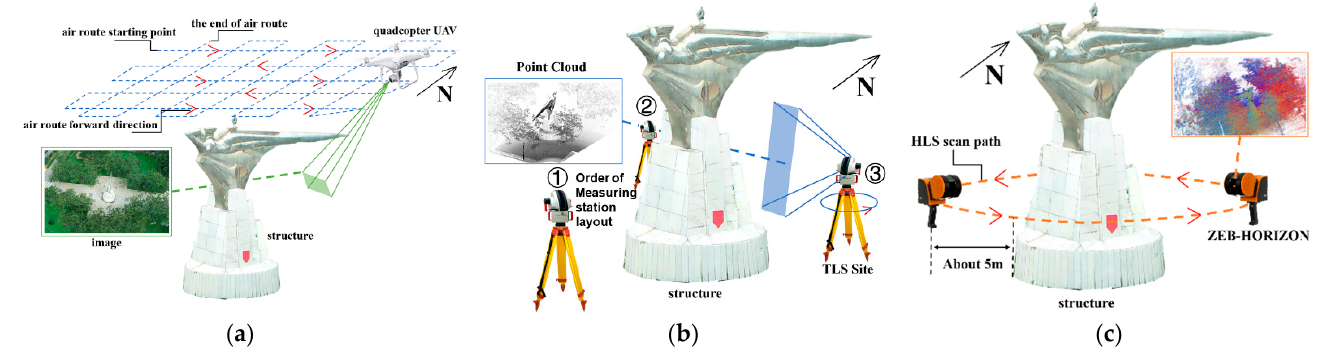
Figure 5. Schematic diagram of each data acquisition path. ( a ) Schematic diagram of the aerial survey route. ( b ) Schematic of the TLS scanning site. ( c ) Schematic of the HLS scan path.